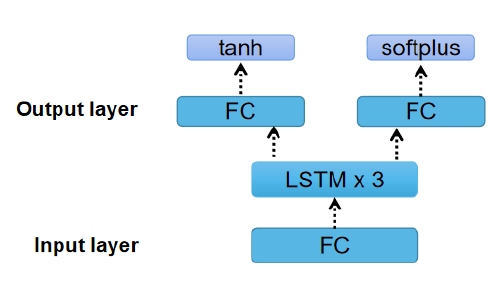
Figure 3. An example of our agent selecting hyperparameters sequentially for CNN model. Agent selects the required hyperparameters for the CNN at each time step and then feeds them to the next time step as input.